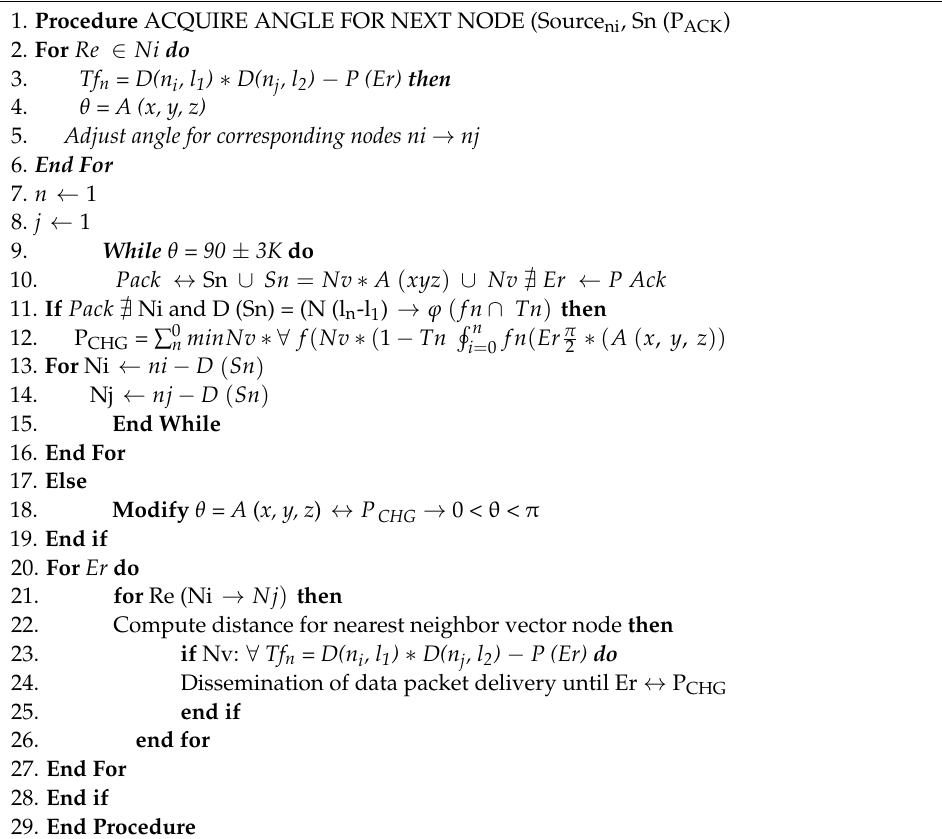
Algorithm 2: Angle Based-Data Packet